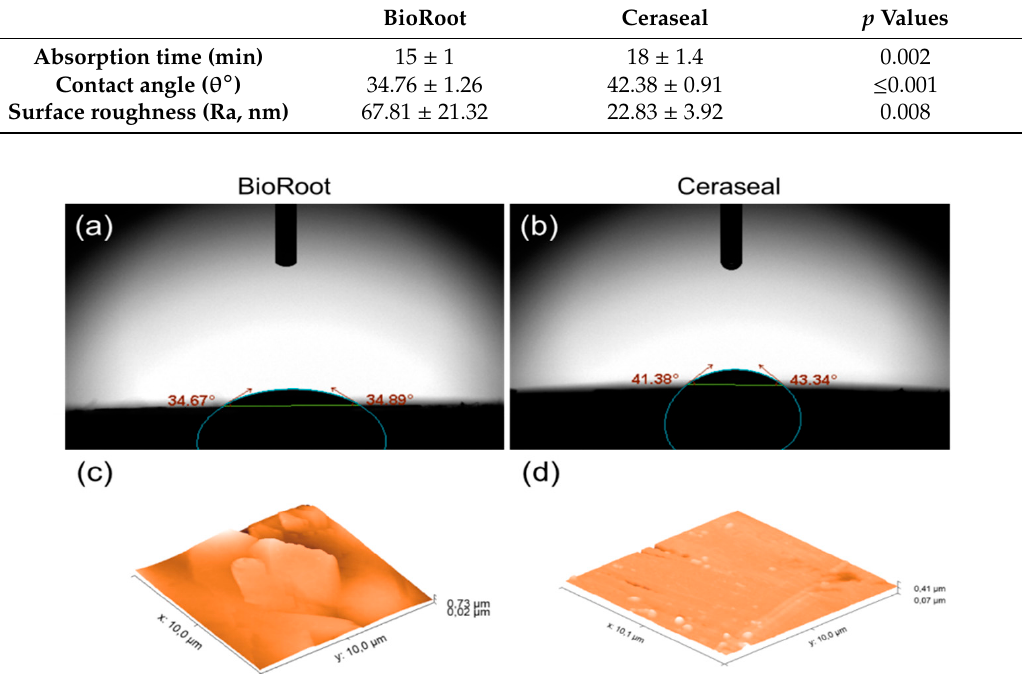
Figure 6. Visual aspect of a water droplet (5 µL in initial volume) deposited onto different sealer surfaces ( a ) BioRoot; ( b ) Ceraseal, 10 s after its deposition. AFM micrographs (3D view, 10 µm 2 ) of the BioRoot surface ( c ) and Ceraseal surface ( d ). Table 5. Evolution of the time required for the two sealers to engulf a 5 µL water droplet, the profile of the water drop after 10 s of deposition on the sealer surface, and the surface roughness mean values and standard deviations.